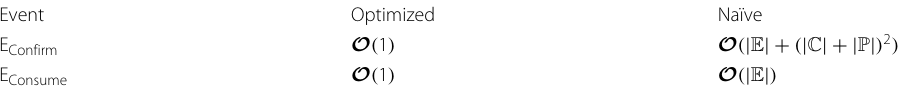
Table 5 Complexity analysis of operations in the Event State Machine when executing the GECKO protocol with confirmed DSO networks Event Optimized Naïve E Confirm O ( 1 ) O ( | E | + ( | C | + | P | ) 2 ) E Consume O ( 1 ) O ( | E |